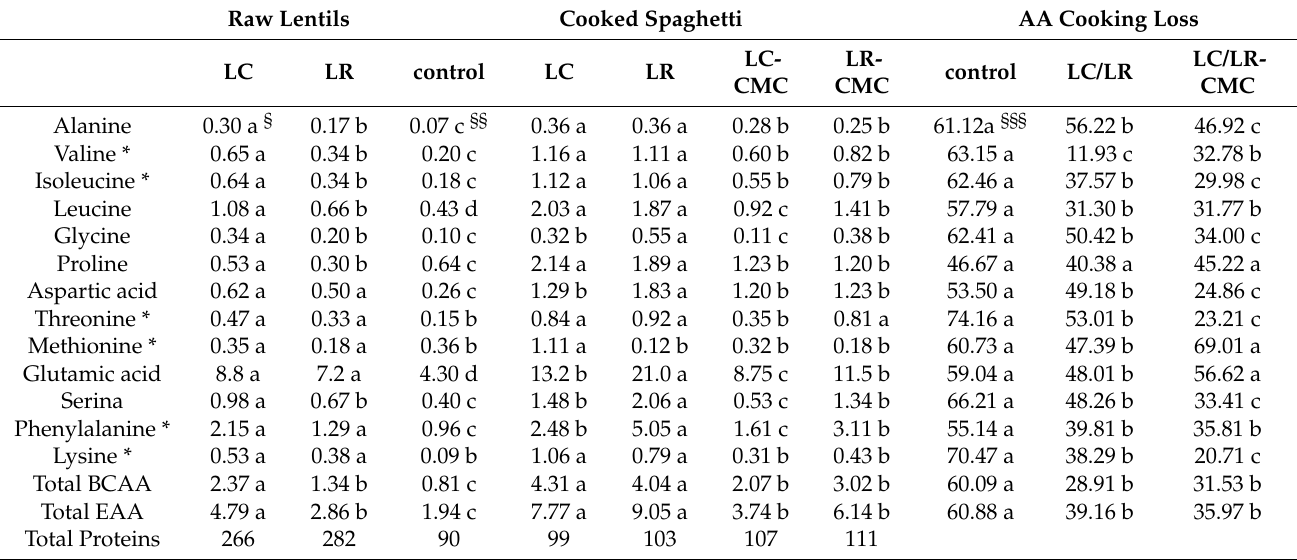
Table 4. Total proteins and amino acid content (mg g − 1 ) in raw lentils and cooked pasta, as well as AA cooking loss (%). Raw